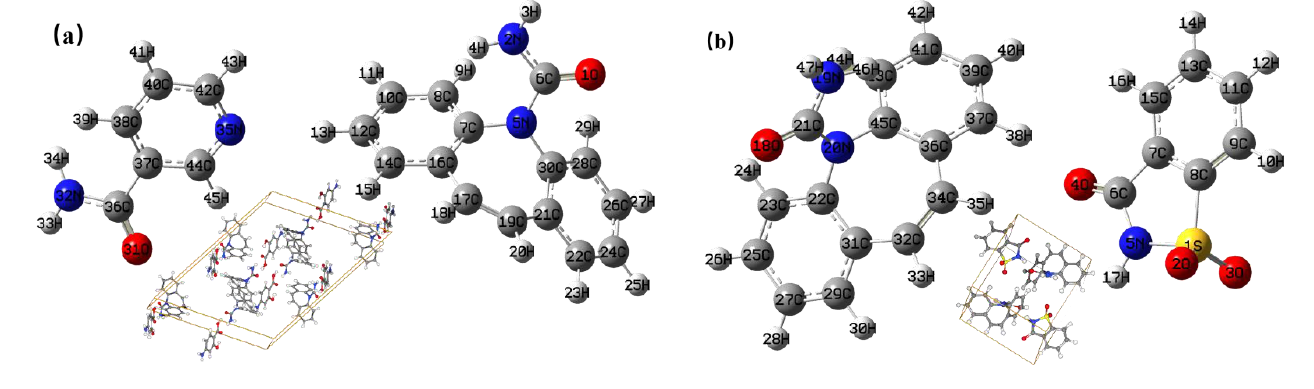
Figure 2. Molecular structures of the co-crystals. ( a ) CBZ and NIC; ( b ) CBZ and SAC.